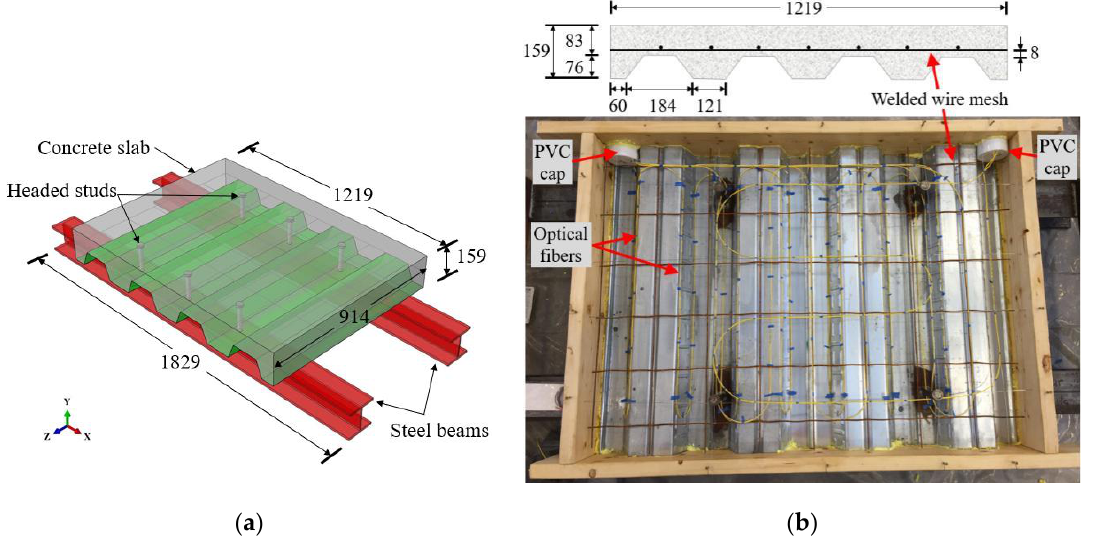
Figure 1. Steel–concrete composite slab specimens (units in mm): ( a ) isometric rendering, and ( b ) cross-sectional and top views. The yellow cables are the optical fibers.